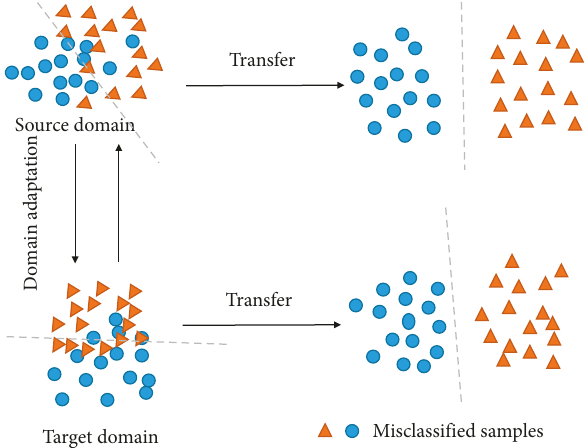
Figure 1: The framework of transfer